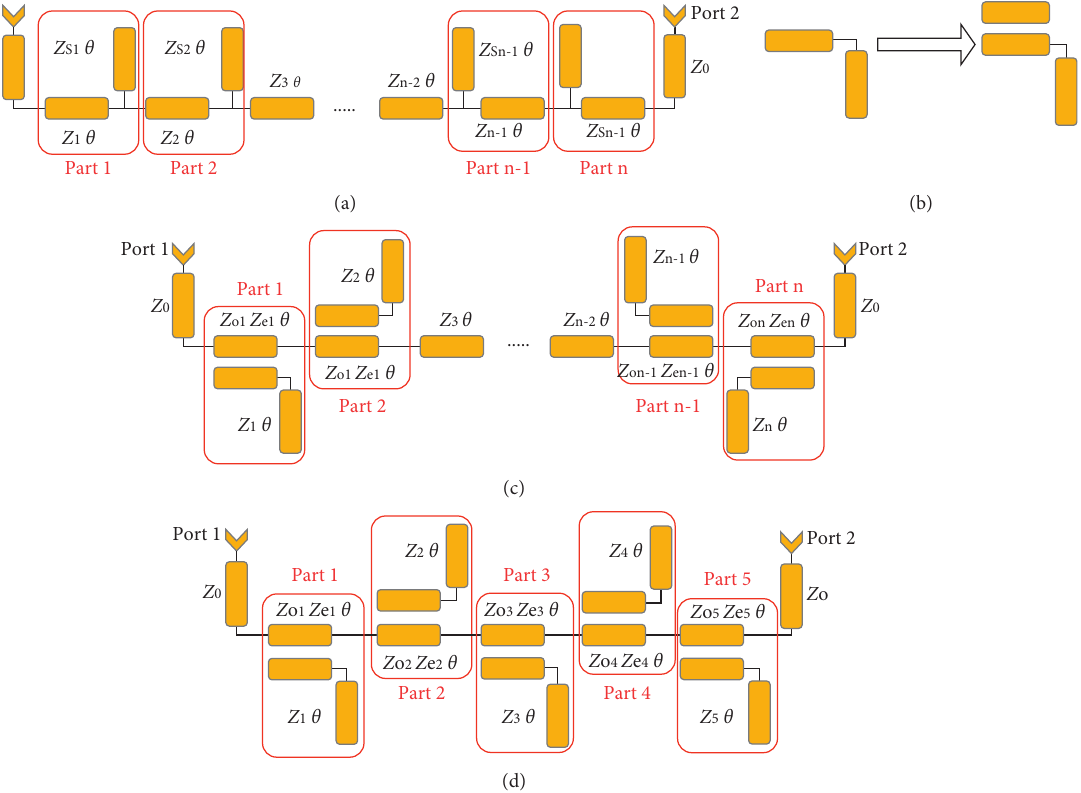
Figure 4: Structure diagram: (a) traditional bandstop filter with multiple parts; (b) equivalent structure; (c) proposed bandstop filter with multiple parts; (d) bandstop filter with five parts.